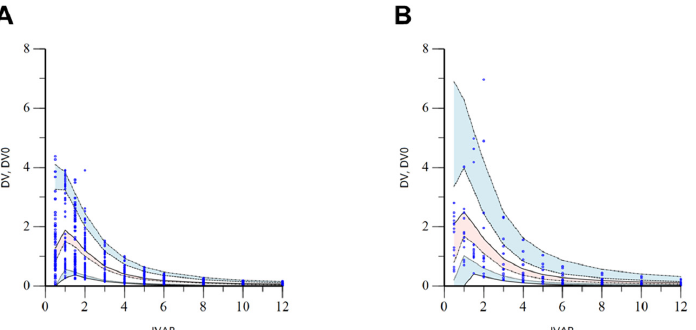
Figure 5. Stratified VPC results by EM ( A ) and IM ( B ) phenotypes of CYP2C9 for the final torsemide Pop-PK model. The dots on the graph represent observations. The black dashed lines mean the 95th, 50th, and 5th percentiles of predicted concentrations, respectively. Blue shaded areas mean 95% CIs for the predicted 95th and 5th percentiles. Red shaded area means 95% CI for the predicted 50th percentile. IVAR ( X -axis) means the time after oral torsemide administration. DV and DV0 ( Y -axis) are observed concentrations of torsemide in the serum and concentrations predicted by the model, respectively.